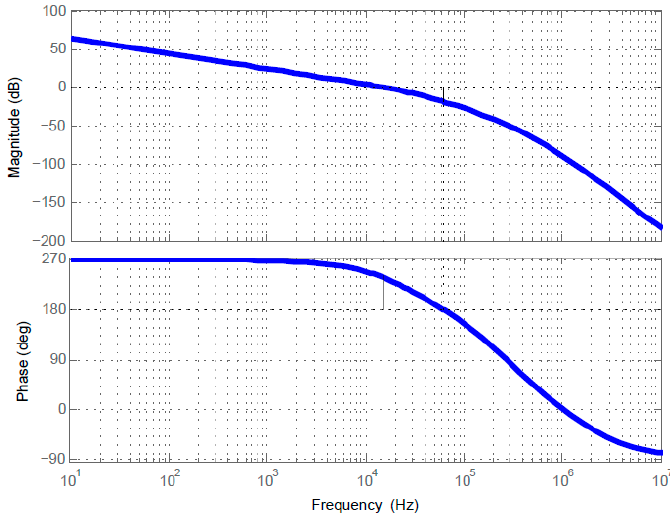
Figure 15. Simulation results and experimental data comparison.